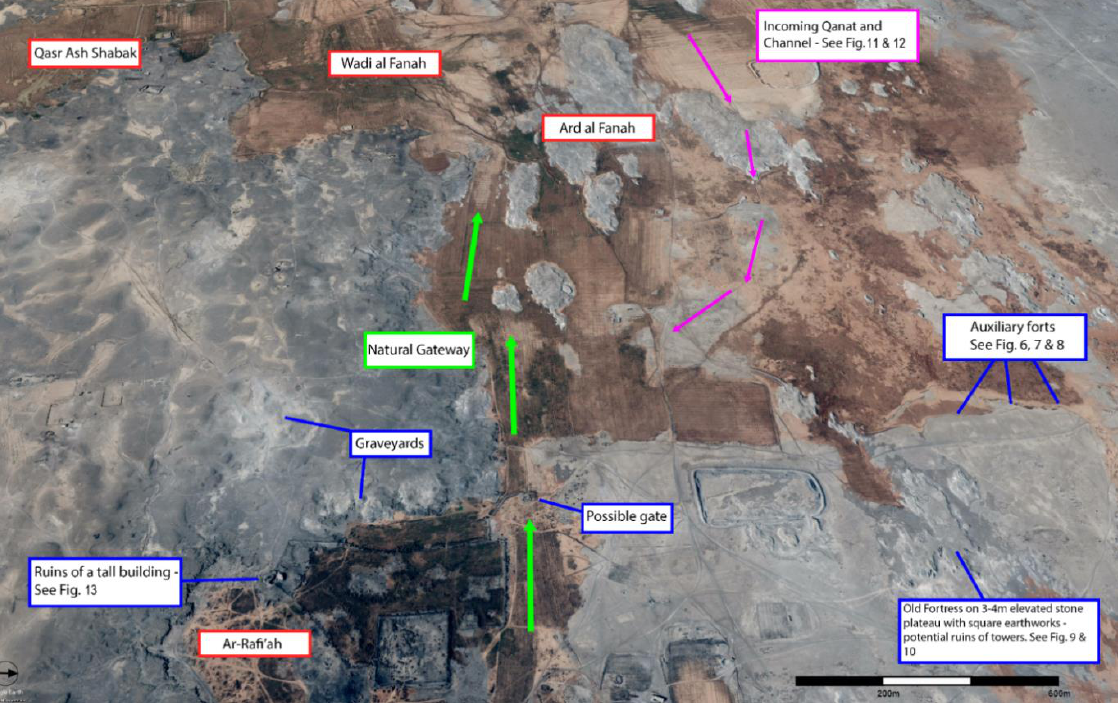
Figure 5: Overview Ar-Rafi’ah / Bir Qassab from East. (Google / Maxar Technologies